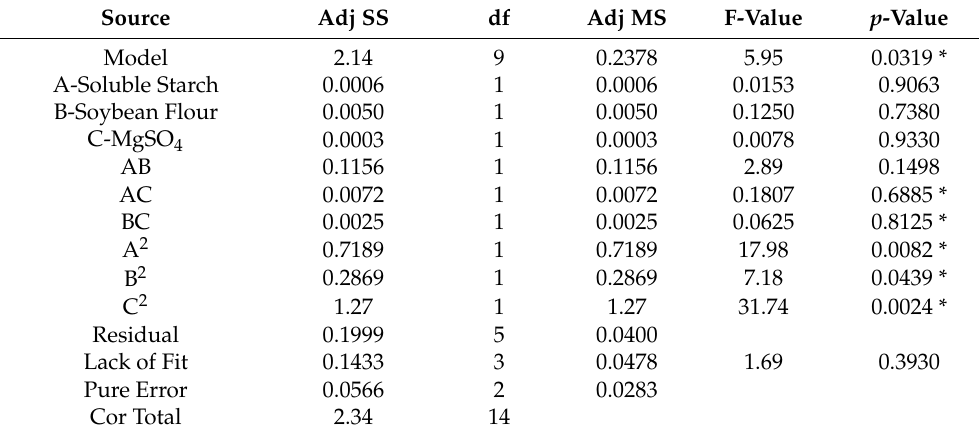
Table 3. Analysis of variance (ANOVA) for response surface quadratic model.